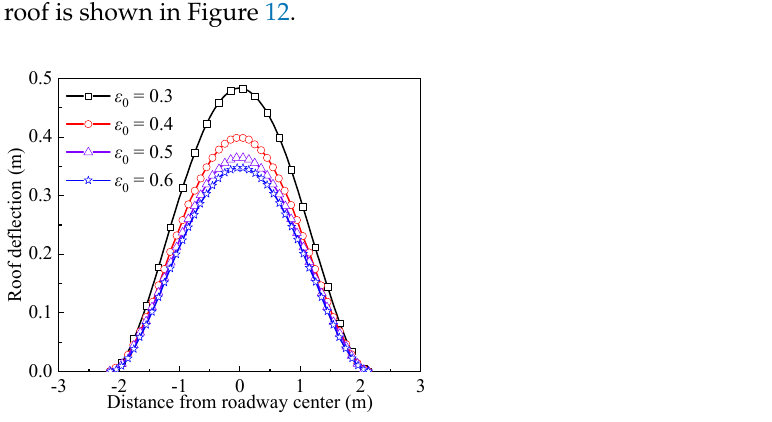
roof is shown in Figure 12.